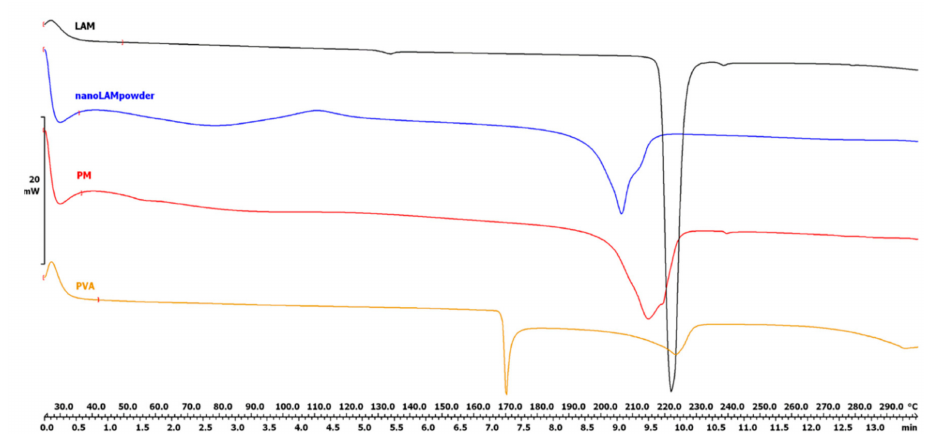
Figure 2. Di ff erential scanning calorimetry (DSC) curves of the